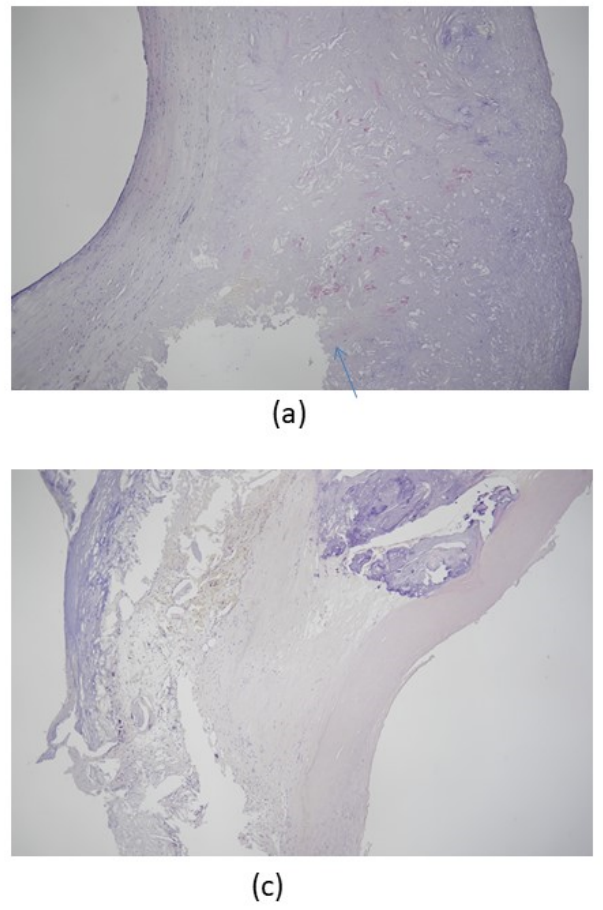
Figure 2. Congo red stain of carotid artery atherosclerosis dissected by carotid endarterectomy. The specimen was fixed in 4% formalin after surgical removal and stained with Congo red for amyloidosis, which colored the A β protein plaque deposits red/salmon pink. ( a ) Congo red stain positive for amyloidosis, 50 × ; ( b ) Congo red stain positive for amyloidosis, 100 × (hypermagnification of a); ( c ) negative control, 50 × . All patients were scheduled for elective therapeutic endarterectomy and gave informed written consent to the procedure. Arrows indicate amyloid deposits in tissue. Images provided by Hayashi, K., Shimane University Hospital, advanced stroke center.